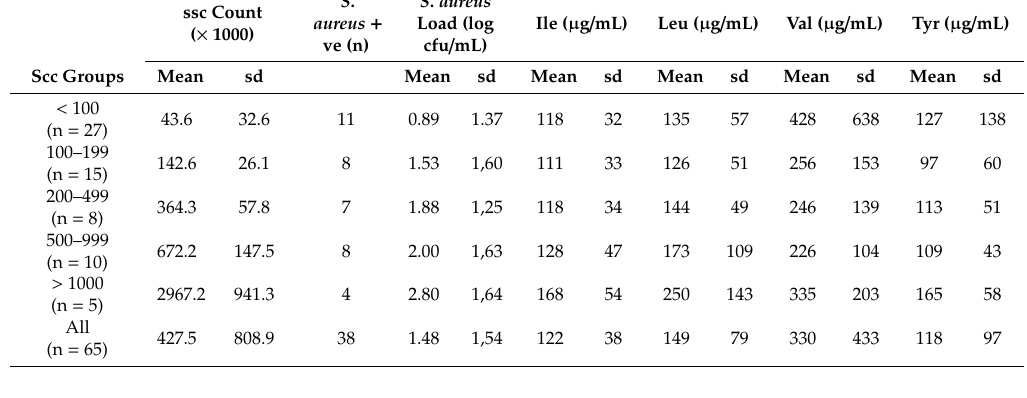
Table 1. SCC, S . aureus load, and selected amino acids content for 65 composite milk samples.